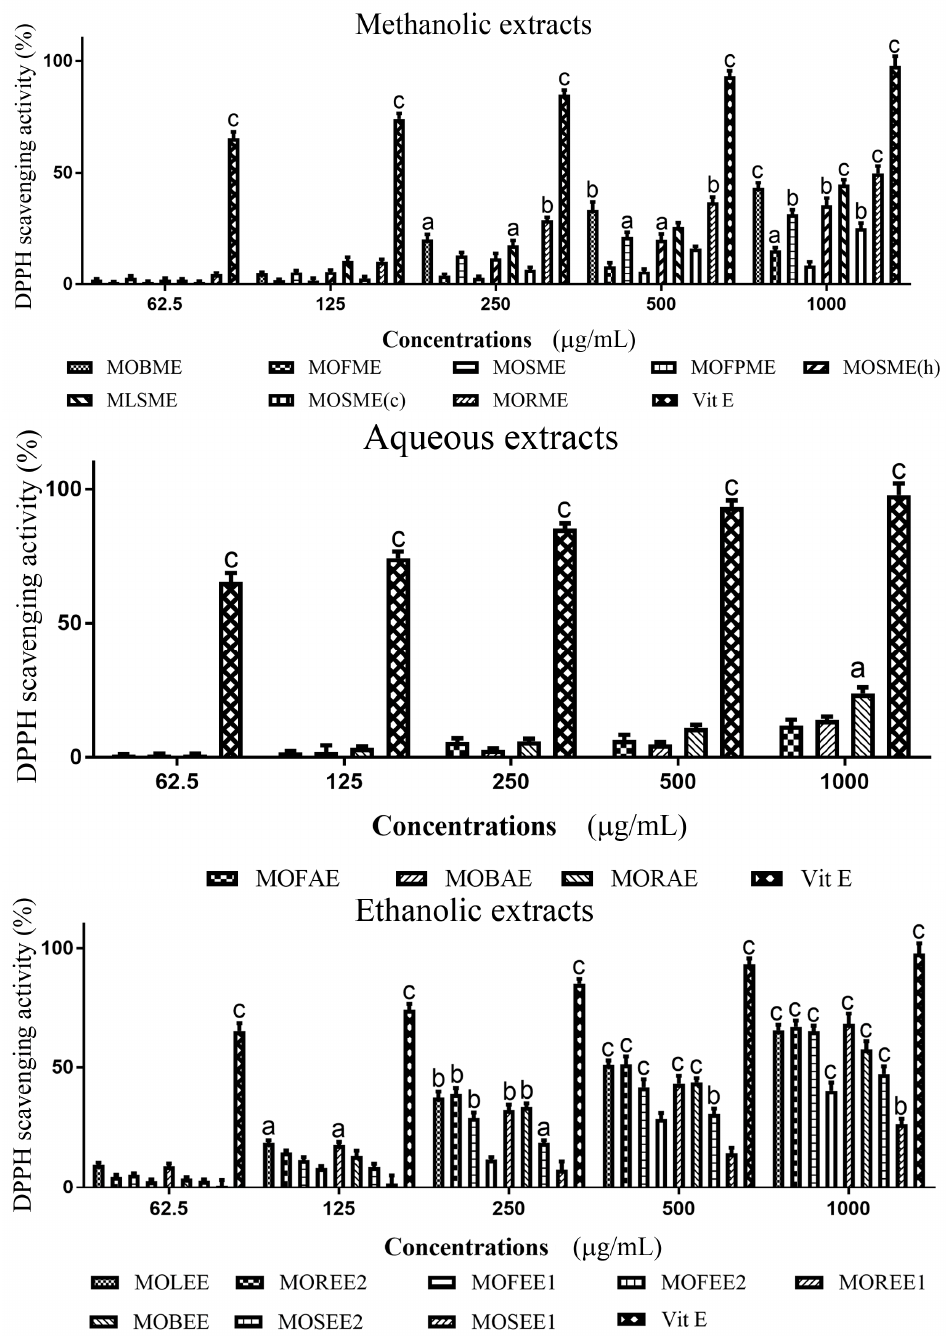
Figure 2. DPPH radical scavenging activity of plant extracts from Moringa oleifera . Plant radical scavenging activity was assessed using a DPPH radical, with results expressed as percentage inhibition. Vitamin E was used as a positive control. The histograms presented are means ± SEM for at least three replicate assays at each extract concentration. a; p < 0.05. b; p < 0.01. c; p < 0.001.